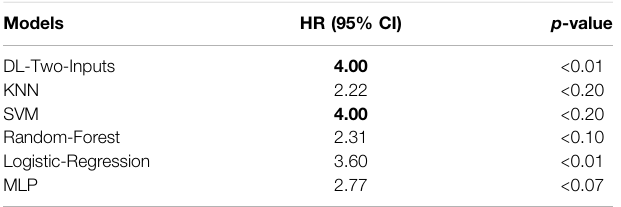
TABLE 4 | Hazard ratio of each model calculated from the univariate proportional hazard analysis model. Models